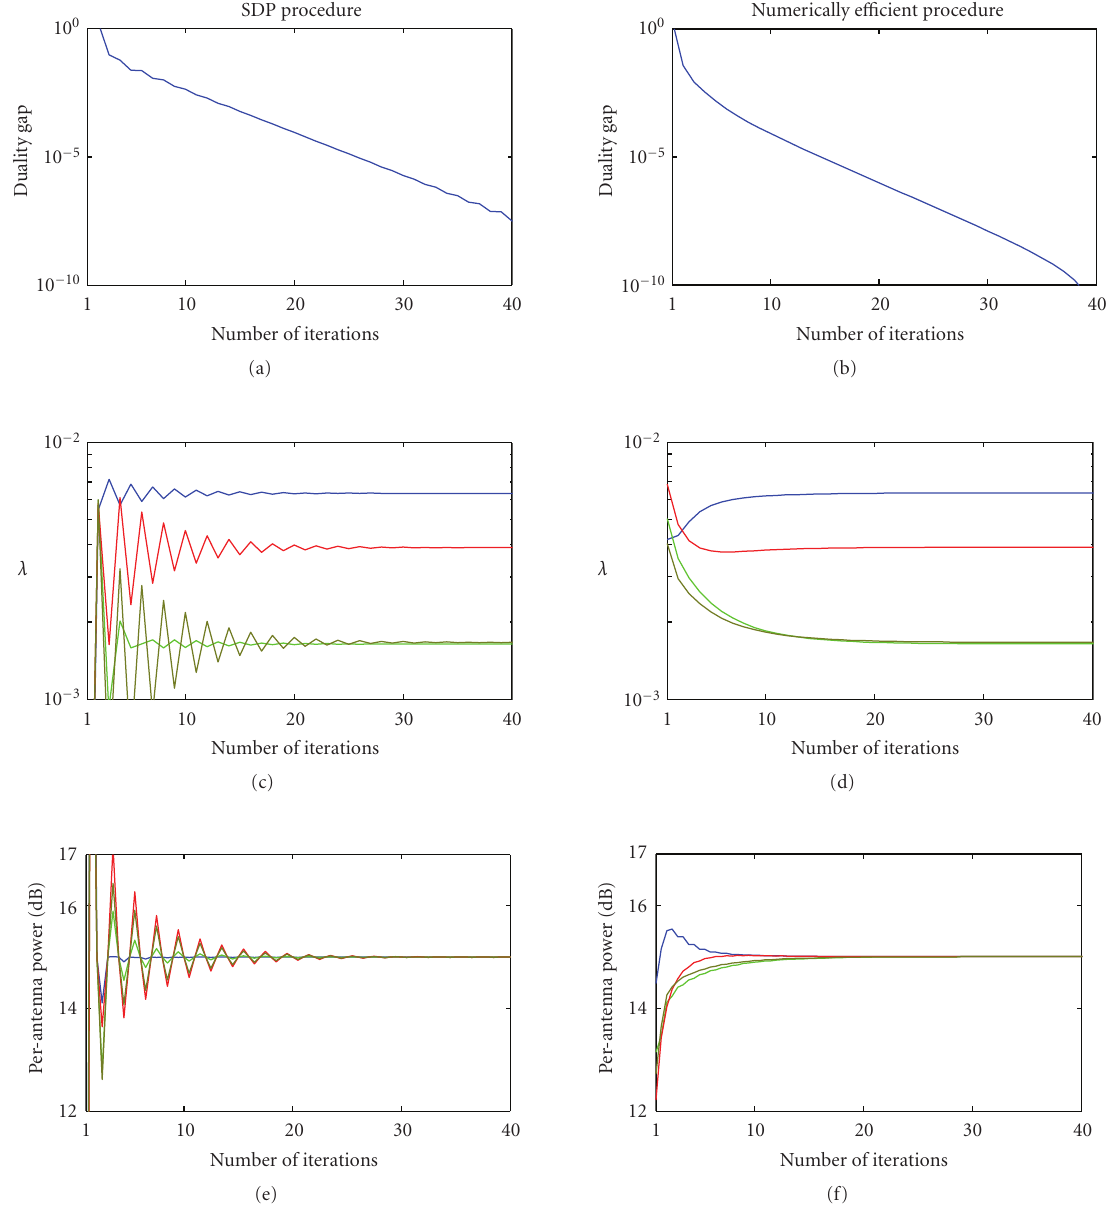
Figure 4: Convergence of the DCOA : duality gap, four Lagrange multipliers, and four per-antenna transmission power, as functions of the number of iterations under the per-antenna power constraint with 10log and two lower subplots correspond to the 4 transmit antennas.